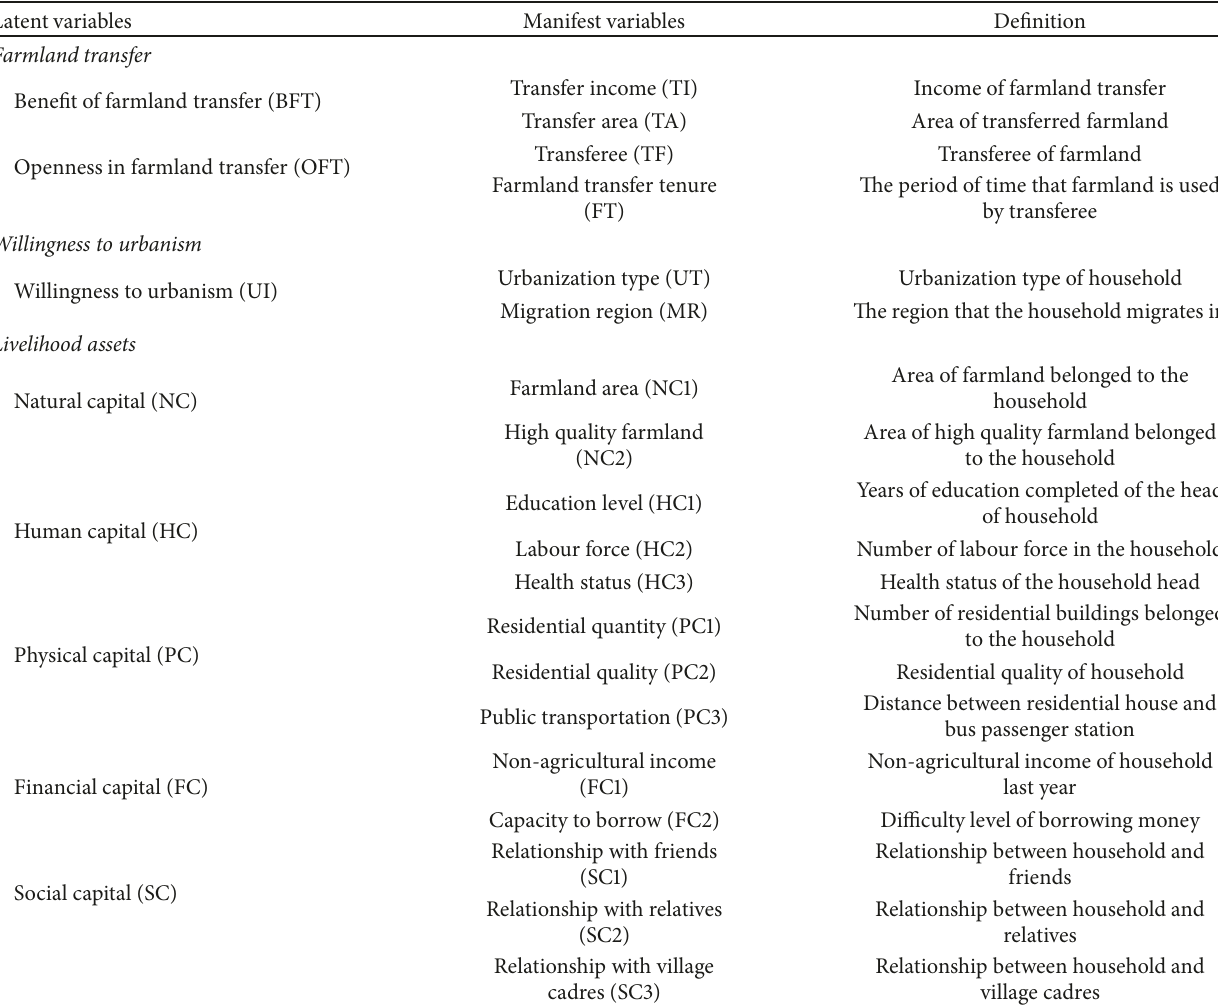
Table 1: Selected variables used in